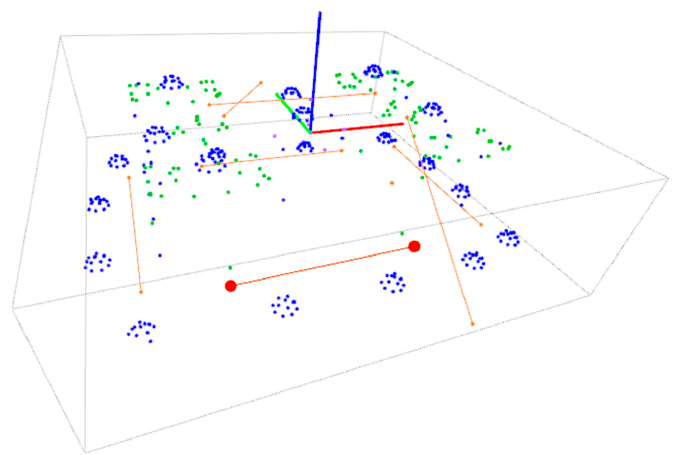
Figure 12. LME approach for precision evaluation, with one calibrated bar as the scale for measurement (red, same scale as in Figure 10a and L3 in Figure 3) and six bars for length error evaluation (orange), all covering the measuring scene of the pilot case under study, with multicoded artifacts (in blue, as shown previously in Figures 2 and 3) and non-coded targets on prismatic subelements (green).